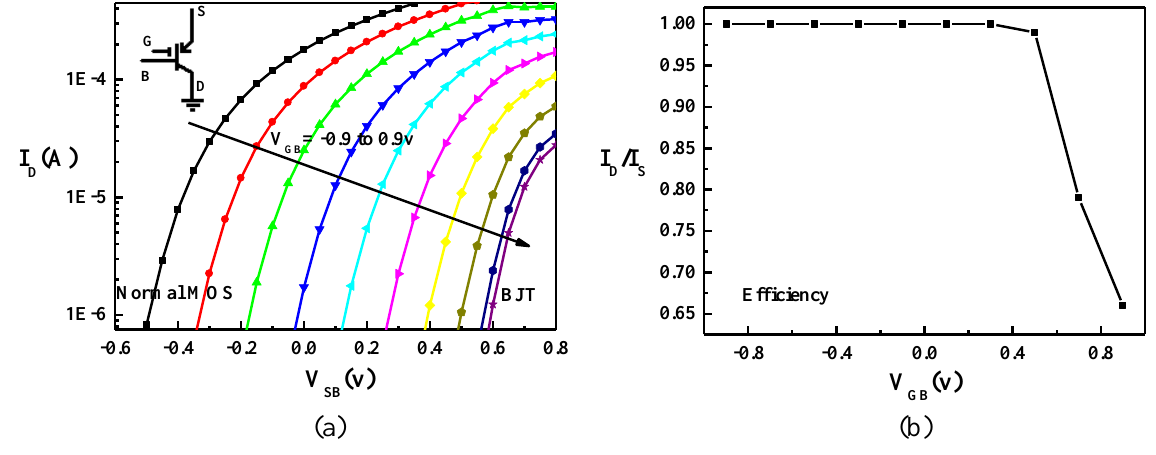
Figure 5. (a) The measured I measured efficiency ( I modes are changed from MOS mode to the LBJT mode by increasing the gate